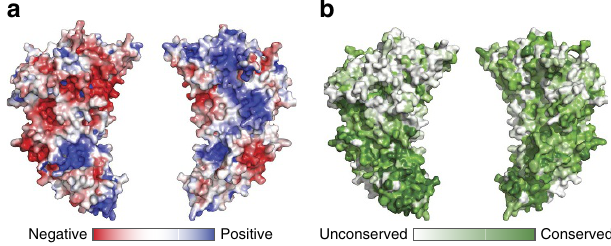
Figure 4 | Surface properties of Tsr1. ( a ) Electrostatic surface calculation for an all-side chain model of Tsr1, calculated using adaptive Poisson- Boltzman solver (APBS). Negatively charged surfaces are red ( (cid:2) 4.5kTe (cid:2) 1 ) and positively charged surfaces are blue ( þ 4.5kTe (cid:2) 1 ). ( b ) Conservation of surface residues as calculated by CONSURF, showing non-conserved surfaces in white and a gradient of conservation in green. NATURE COMMUNICATIONS|7:11789|DOI: